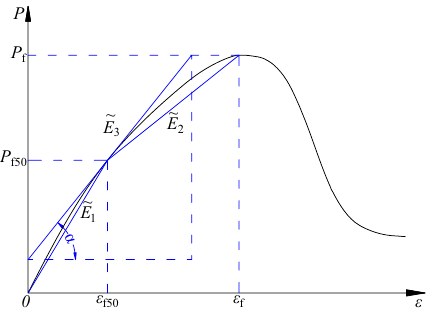
Figure 3. Schematic diagram of the method for defining the apparent deformation modulus of circular